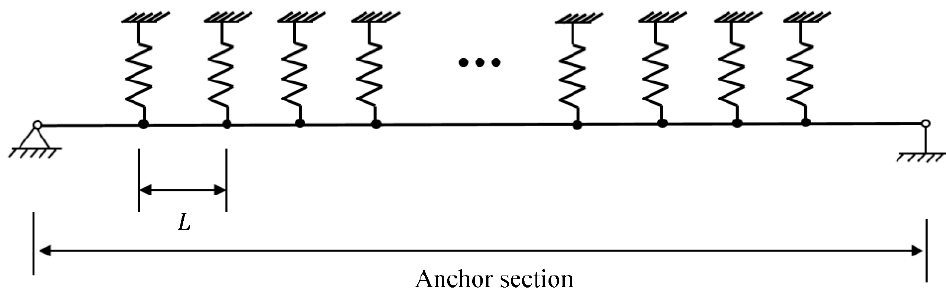
Figure 5. A simplified schematic of the layout of the rigid catenary. Inputting the boundary condition as per Equation (2) and the initial condition as per Equation (3), the harmonics vibration equation as per Equation (4) and the mode shape orthogonality as per Equation (5) all into Equation (1), together with the Rayleigh damping model of Equation (6), the equation of motion of the rigid catenary system can be written as Equation (7)